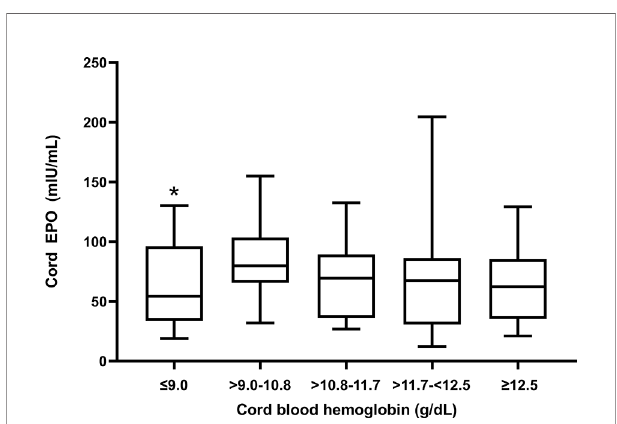
FIGURE 2 | Cord blood EPO levels in relation to degree of fetal anemia. Q1 (Hb ≤ 9 mg/dl); Q2 (Hb > 9 -10.8 mg/dl); Q3 (Hb >10.8-11.7 mg/dl); Q4 (Hb > 11.7-<12.5 mg/dl; and Q5, no fetal anemia ( ≥ 12.5). The box plots indicate the median (horizontal line) and interquartile range (box), and the whiskers represent 10 th /90 th percentiles. The differences between groups were analyzed by the Kruskal-Wallis test; *Q1 was signi fi cantly lower than the reference group Q5 (p =